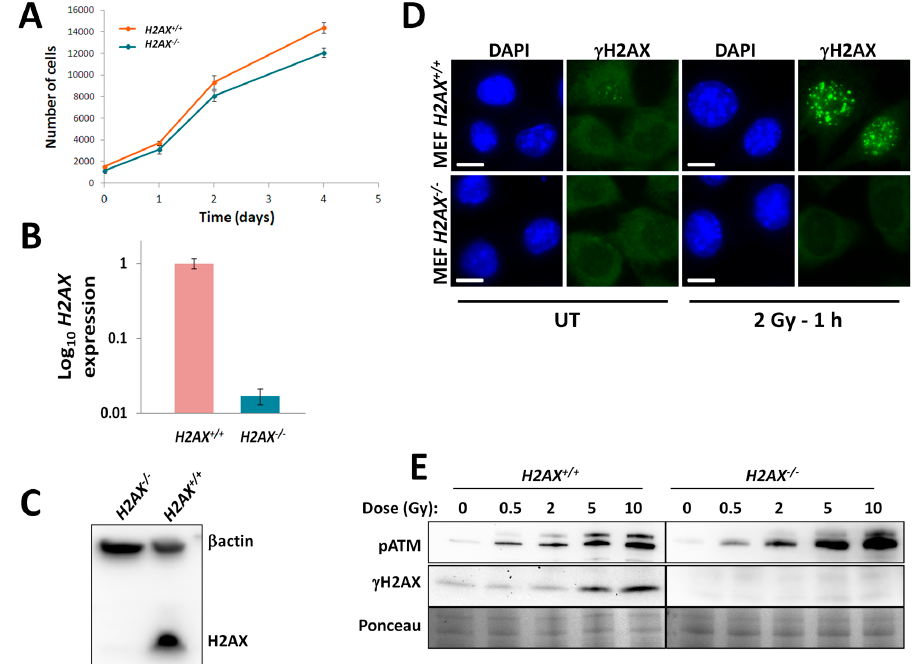
Figure 1. Characterization of mouse embryonic fibroblasts (MEF) H2AX + / + and H2AX − / − cells. ( A ) Growth curves of untreated MEF H2AX + / + and H2AX − / − cells; ( B ) basal H2AX gene expression in MEF H2AX + / + compared to H2AX − / − cells measured by RT-qPCR; ( C ) Western blot showing lack of H2AX protein in H2AX − / − cells; ( D ) representative microscopic images of cells showing γ H2AX foci (green fluorescence) observed at 1 h after sham-(UT, untreated) or 2 Gy irradiation of MEF cells. Nuclear perimeters were obtained by processing the DAPI (4 1